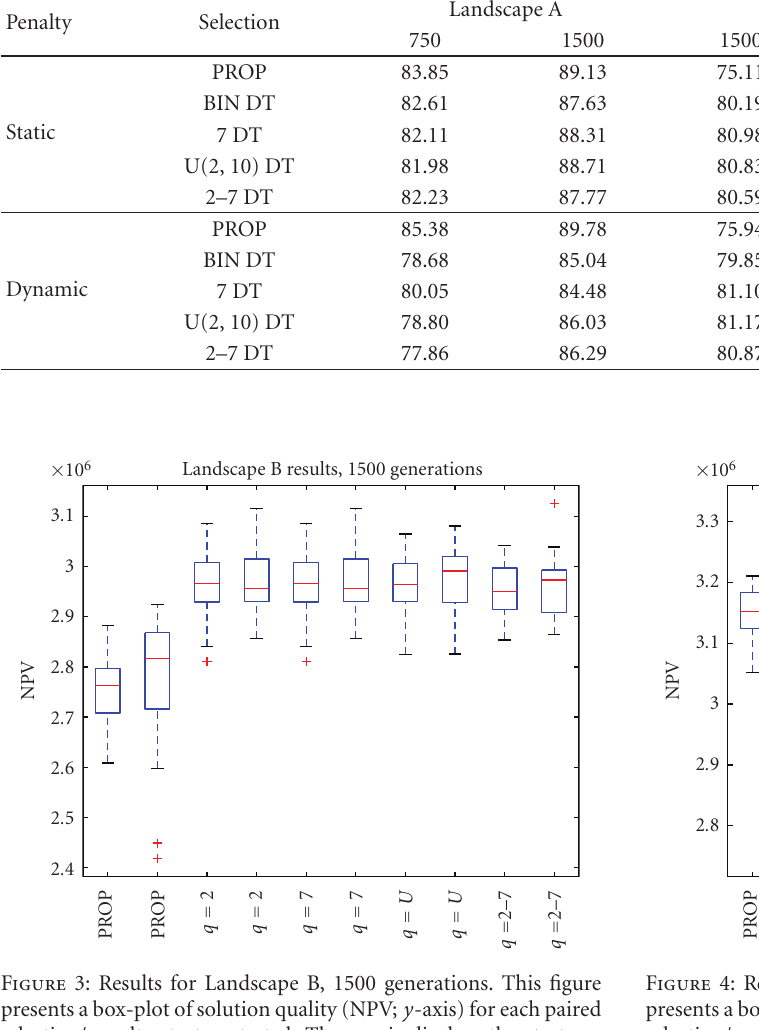
best selection/penalty pairs for landscapes A (1500 genera- tions), B (3000 generations), and C (6000 generations) were proportional/dynamic (89.78%), q = 7/dynamic (88.31%), and proportional/dynamic (88.00%), respectively. Based on these results we selected the proportional/dynamic strategy for further